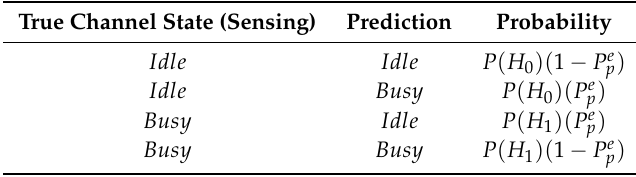
Table 2. True channel state and prediction